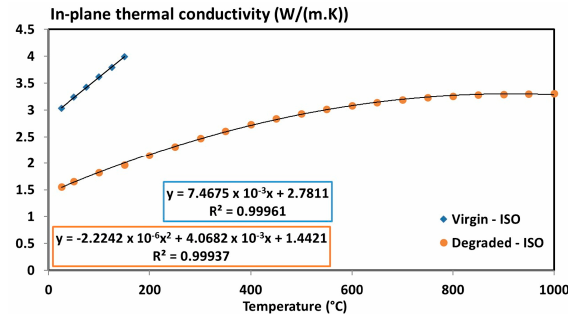
Figure 9. In-plane thermal conductivity of the T700/M21 composite (virgin and degraded state) as a function of the temperature [6].